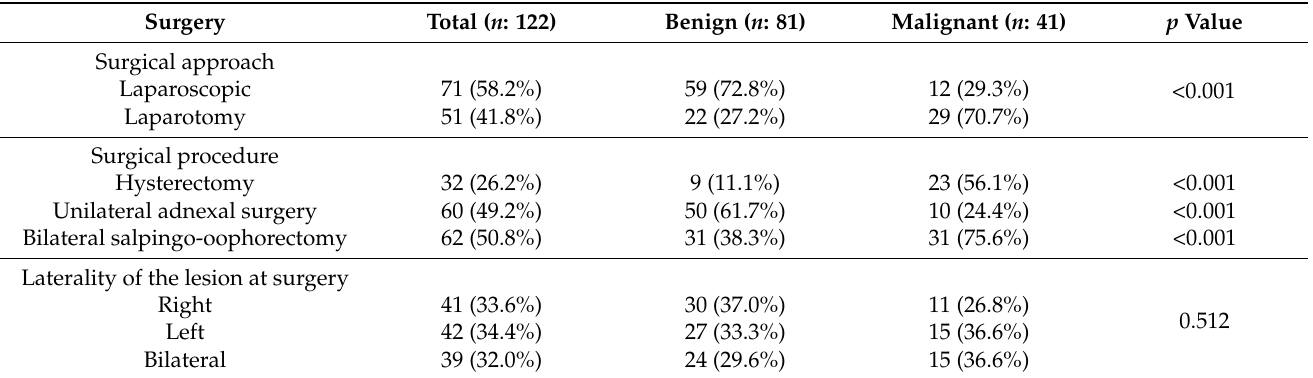
Table 6. Surgical procedures and surgical